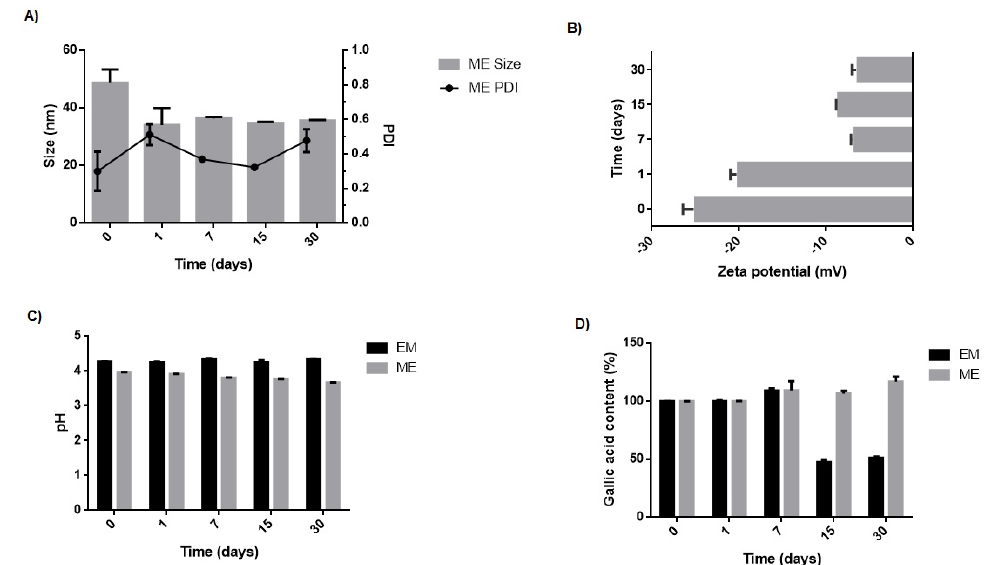
Figure 6. Evaluation of average size and PDI ( A ), zeta potential ( B ), pH ( C ), and GA content ( D ) of the microemulsion (ME) and conventional emulsion (EM) stored at room temperature over 0, 7, 15, and 30 days.